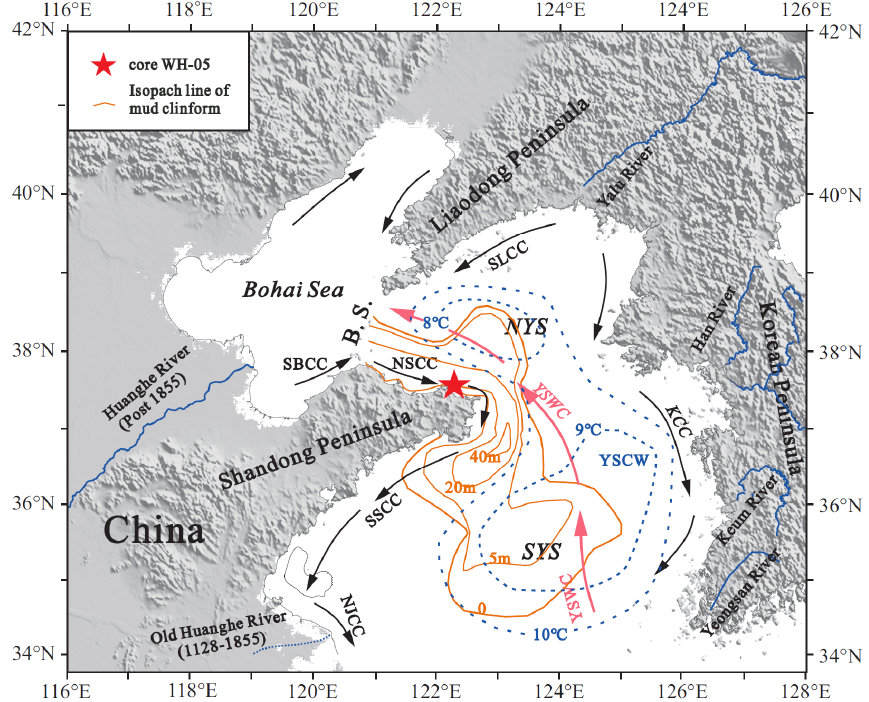
Figure 1. Winter circulation and location of the subaqueous clinoform off Shandong Peninsula and core WH-05 (modified from [16]). NSCC = North Shandong Peninsula Coastal Current, SLCC = South Liaoning Coastal Current, KCC = Korean Peninsula Coastal Current, SBCC = South Bohai Coastal Current, SSCC = South Shandong Peninsula Coastal Current, SYS = South Yellow Sea, NJCC = North Jiangsu Coastal Current, YSWC = Yellow Sea Warm Current, YSCW = Yellow Sea Cold Water, B.S. = Bohai Strait.